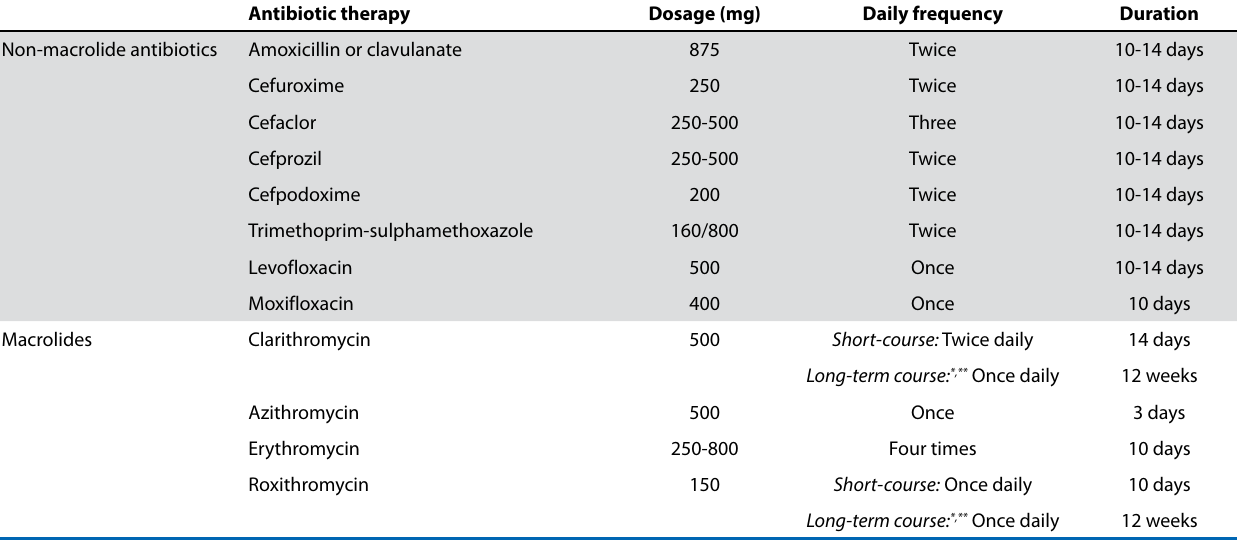
Antibiotic therapy